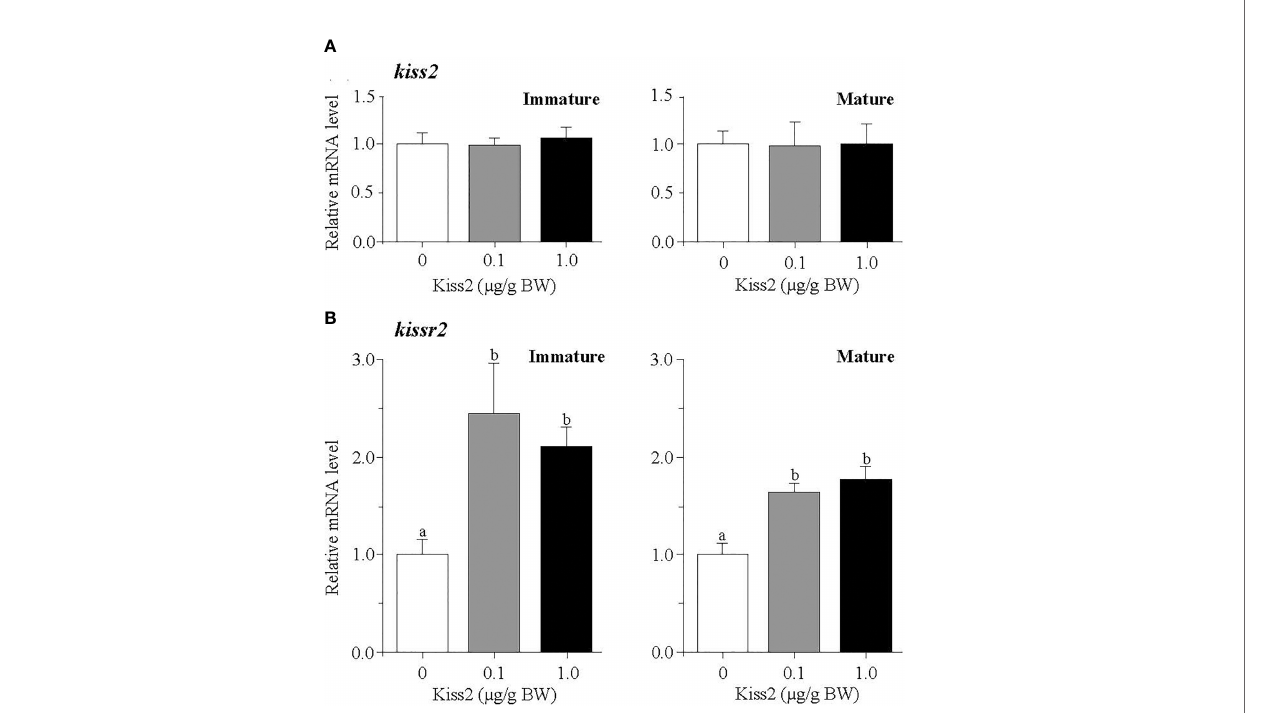
FIGURE 1 | Changes in the relative mRNA levels of kiss2 (A) and kissr2 (B) in the brain of grass puffer at immature and mature stages after intraperitoneal injection of gpKiss2 for the period of 12hrs. Values are presented as mean ± SEM (n = 6 − 8). Values accompanied by different letters are statistically signi fi cantly different ( p <